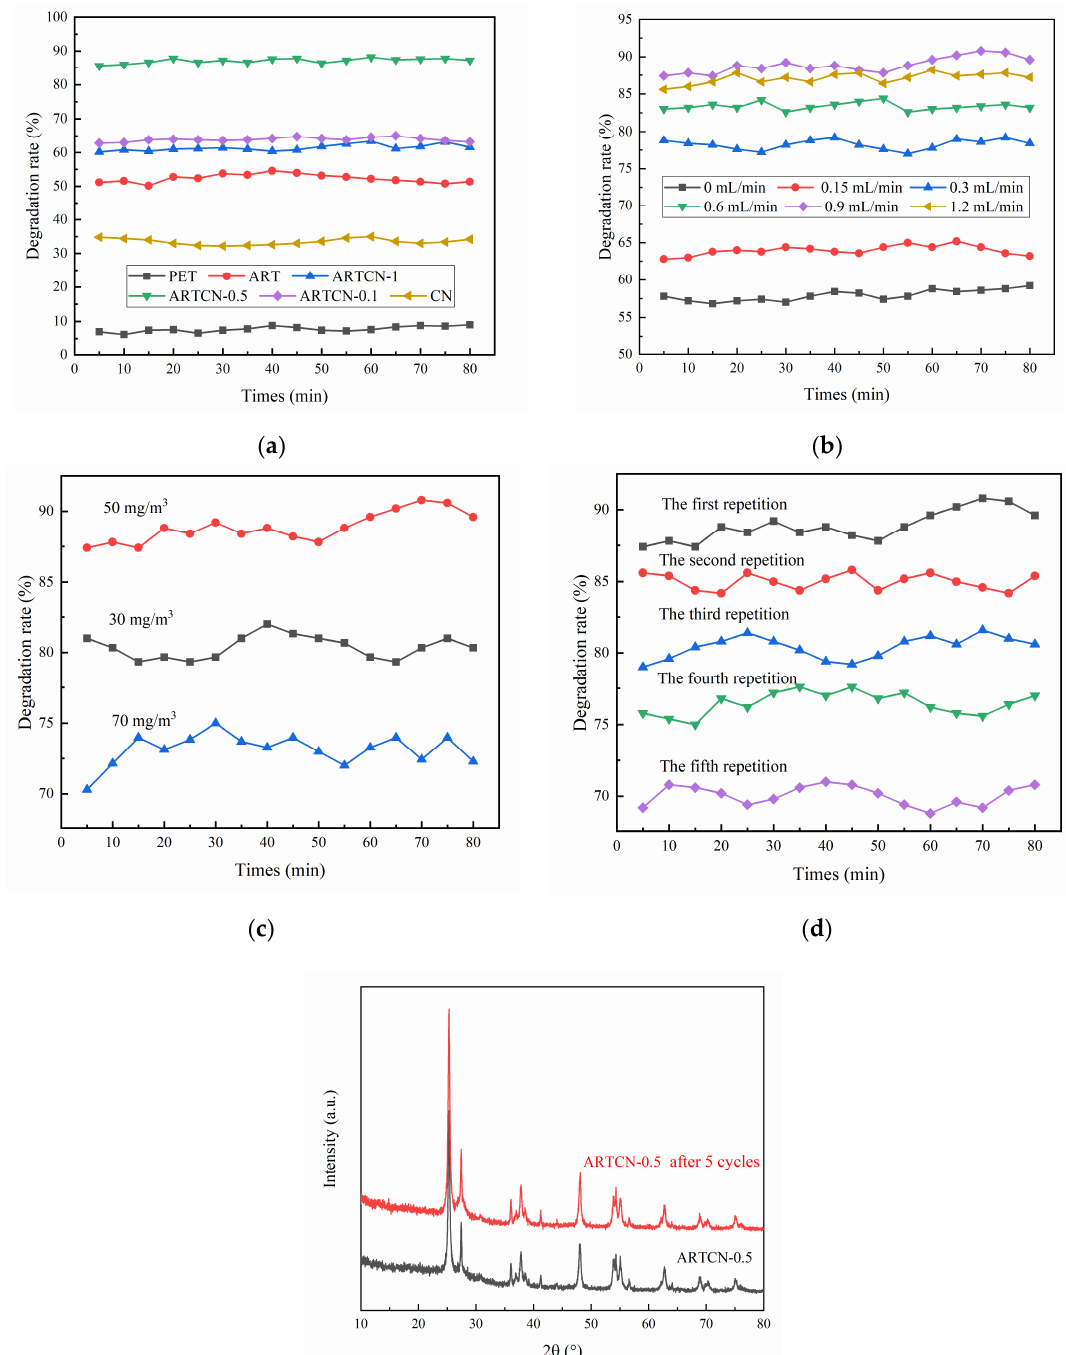
Figure 7. Influence of different catalysts on the degradation of gaseous ammonia ( a ), the effect of different humid air flow rates on the degradation of gaseous ammonia ( b ), the effects of different ammonia concentrations on the degradation of gaseous ammonia ( c ), the repeated degradation performance of ARTCN-0.5 ( d ), and XRD patterns before and after the repeated use (5 times) of ARTCN-0.5 ( e ).